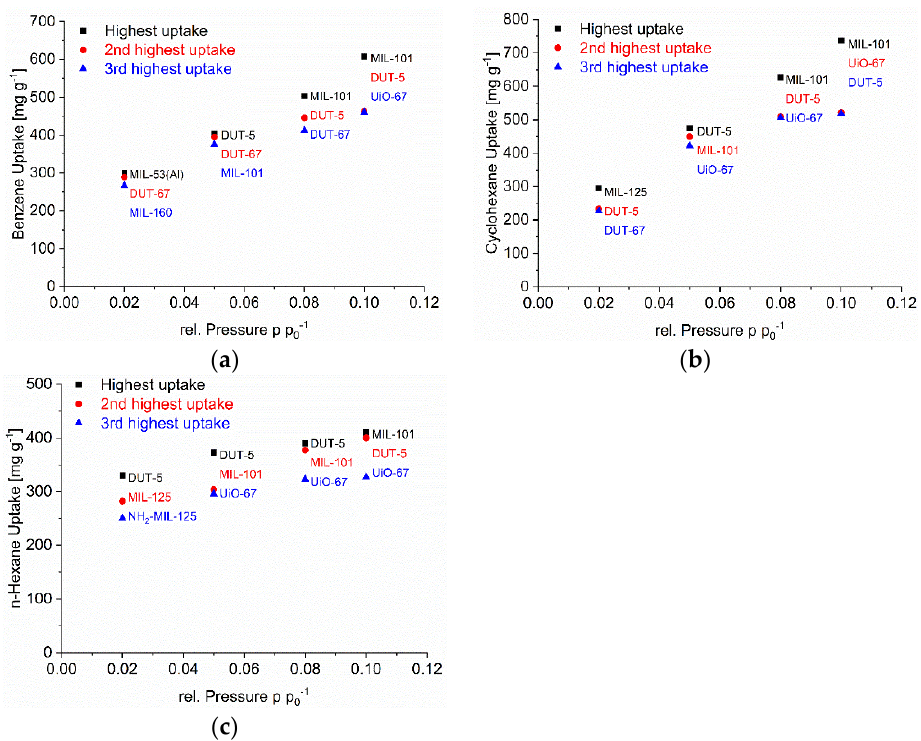
Figure 6. Top three MOFs with the highest C 6 vapor at each relative pressure of p p 0 − 1 = 0.1, 0.08, 0.05 and 0.02 for ( a ) benzene, ( b ) cyclohexane, and ( c ) n -hexane.